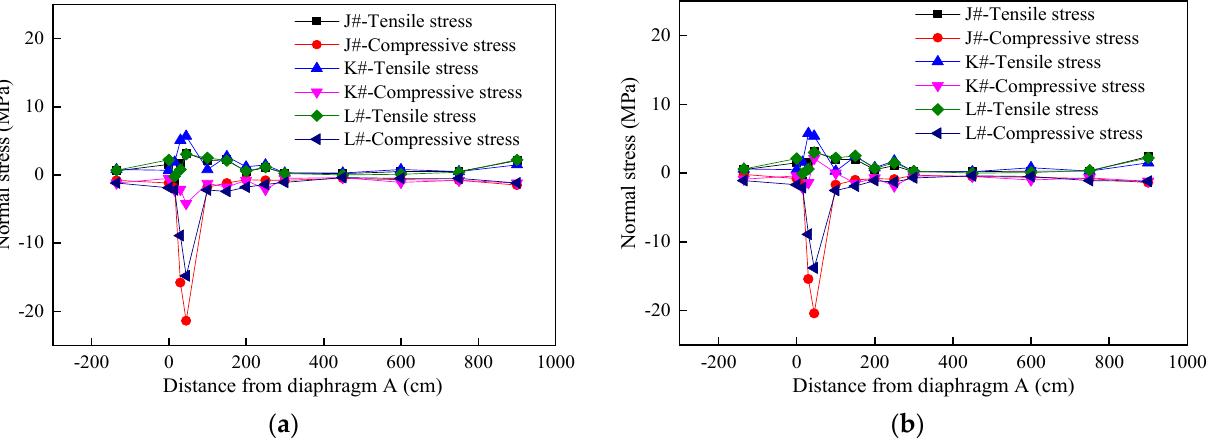
Figure 24. Longitudinal loading 105# diaphragm (notch optimization) bridge deck stress-load position relationship curve: ( a ) Before optimization, ( b )after optimization.